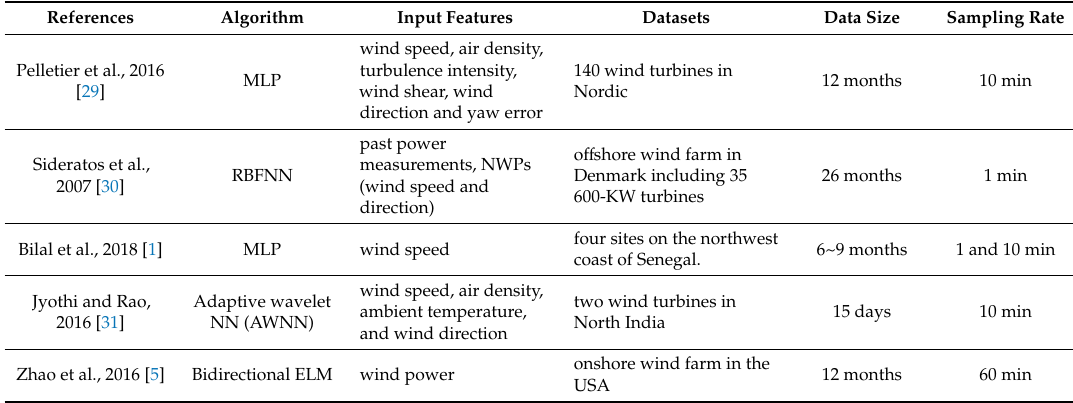
Table 3. ANN wind power prediction